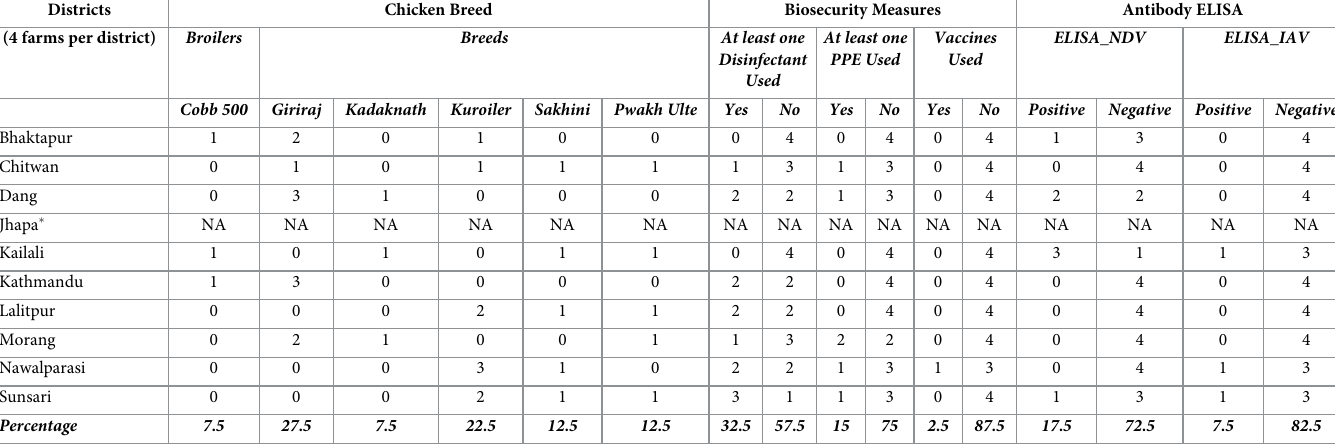
Table 6. Biosecurity practices in backyard farms(n = 36) of Nepal along with antibody ELISA results for NDV and IAV. ELISA results provide an insight into any possible correlations between biosecurity measures and presence of diseases. Districts